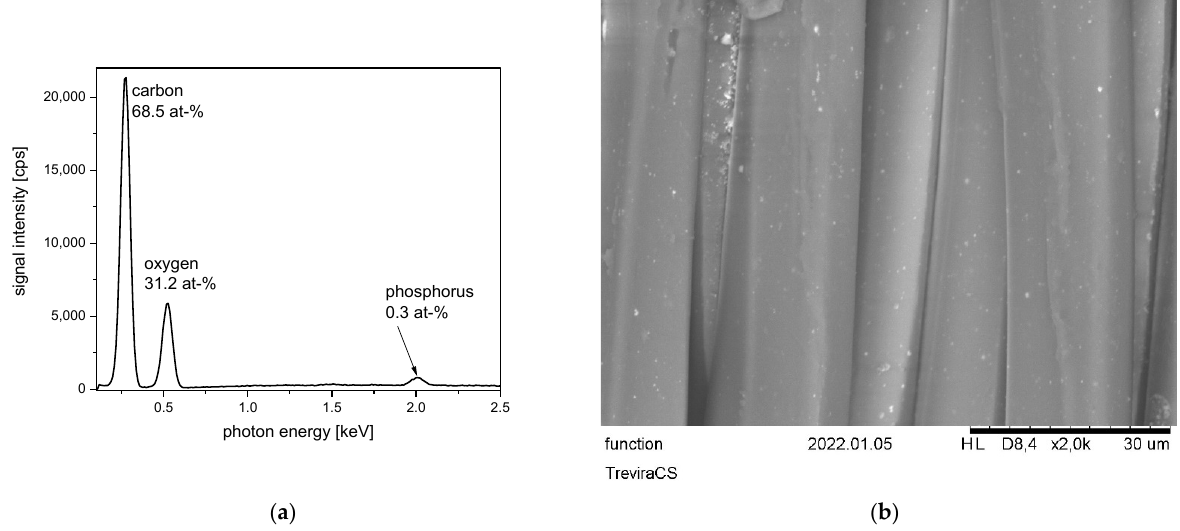
Figure 21. Commercially available fabric made from functional polyester TreviraCS—( a ) EDS spec- trum; ( b ) SEM image.